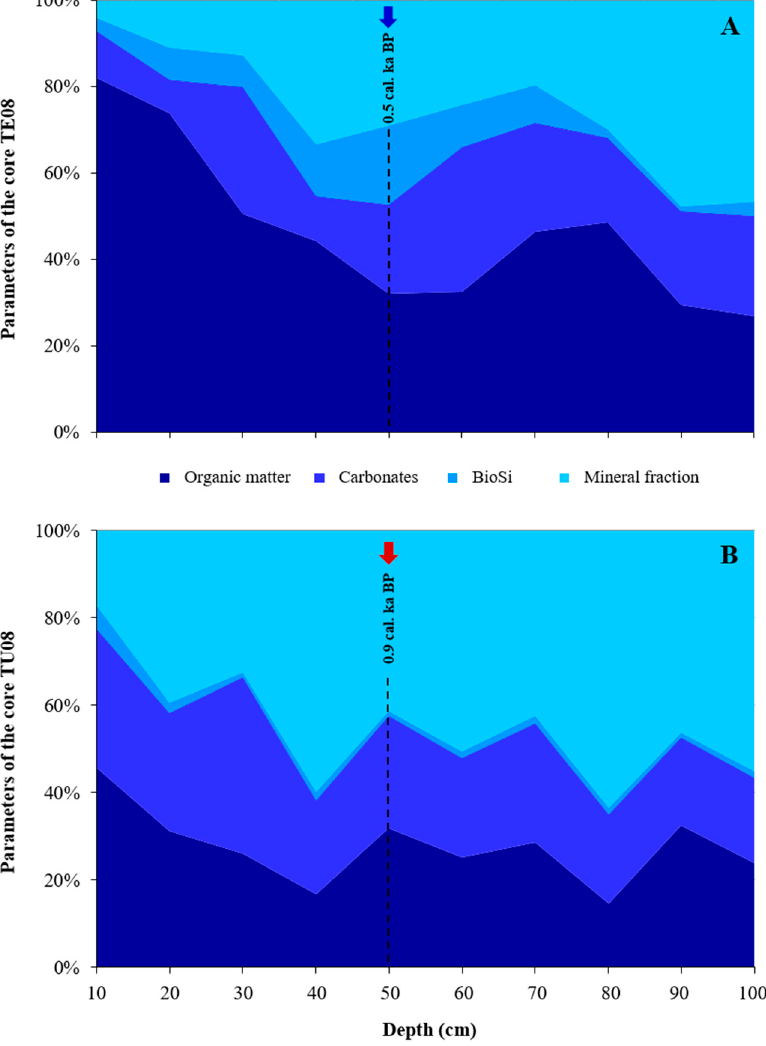
Figure 4. Physical and chemical parameters with the ages for the cores ( A ) TE08 and ( B ) TU08: organic matter, carbonate, BioSi, and mineral fraction.